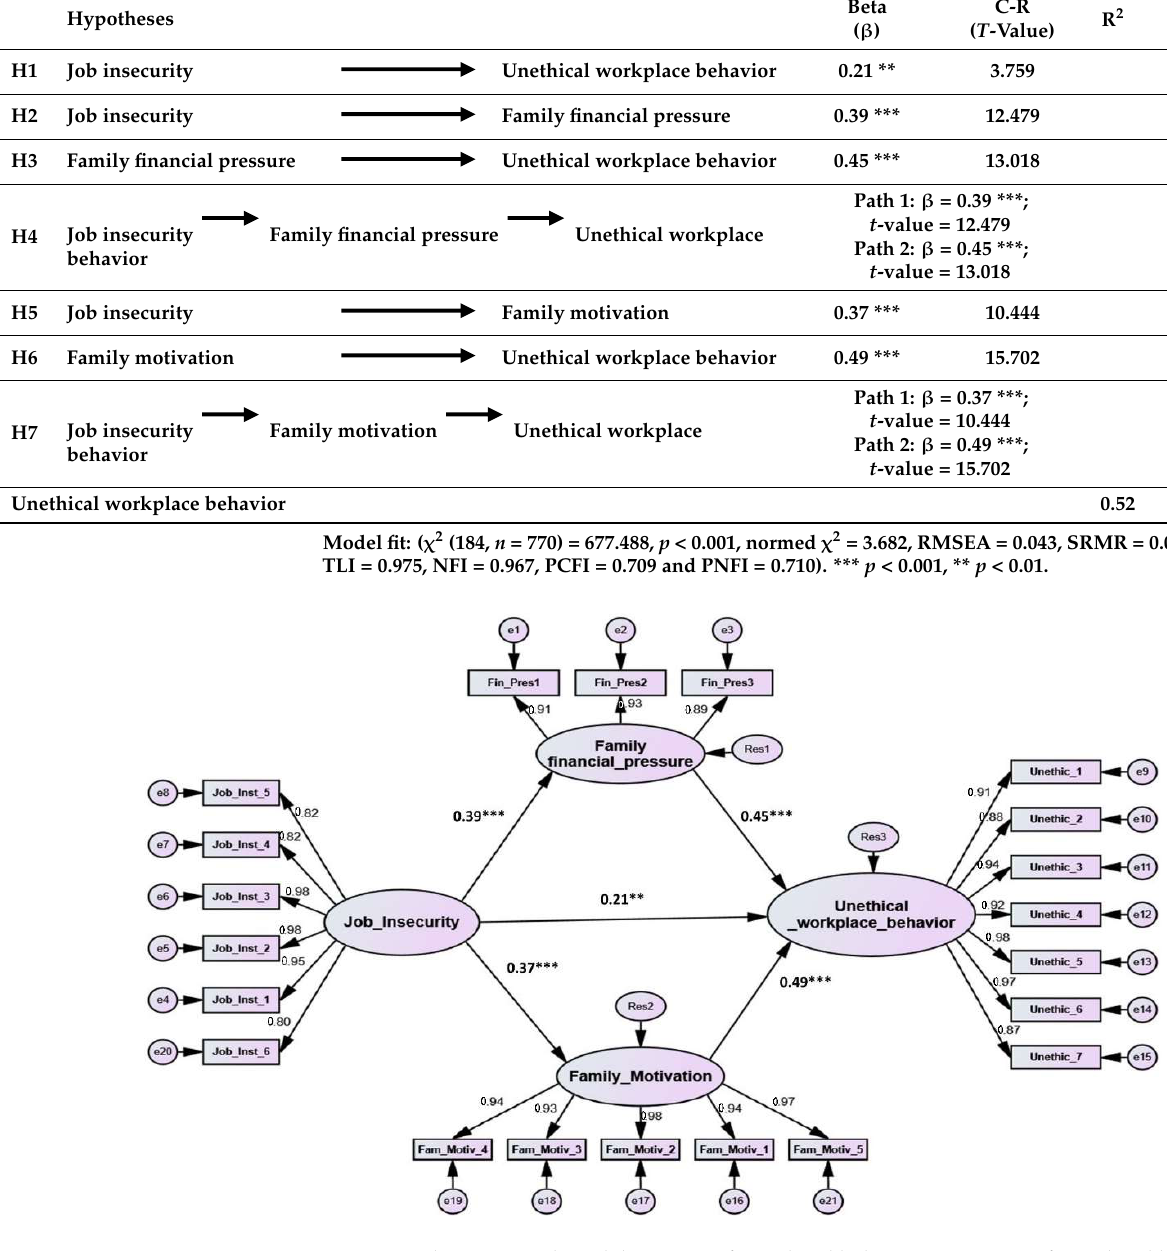
Table 3. Result of structural model.